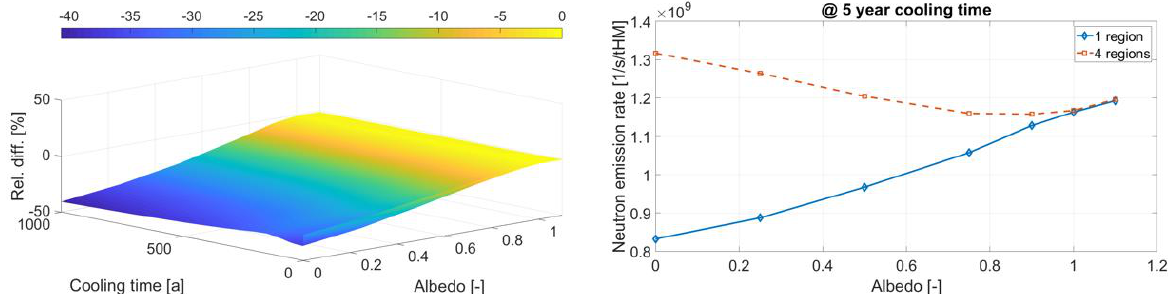
Figure 8. Differences in neutron emission rate between 1 region and 4 region cases as a function of albedo and cooling